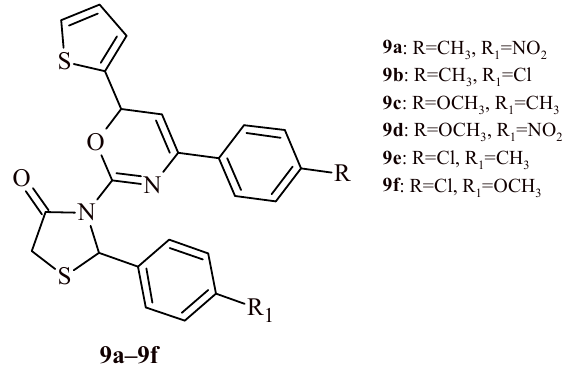
The Compound 9a showed highest antioxidant activity with IC 50 values of 6.62 µg/mL (DPPH assay) and 6.79 µg/mL (NO assay). Compound 9c was also worthy of attention because it exhibited antioxidant activity at concentration 9.33 and 6.05 µg/mL, corre- spondingly for DPPH and NO tests. Other derivatives showed less antioxidant activity than standard ascorbic acid (IC 50 values of 22.88 µg/mL for DPPH assay and 12.61 µg/mL for NO test).